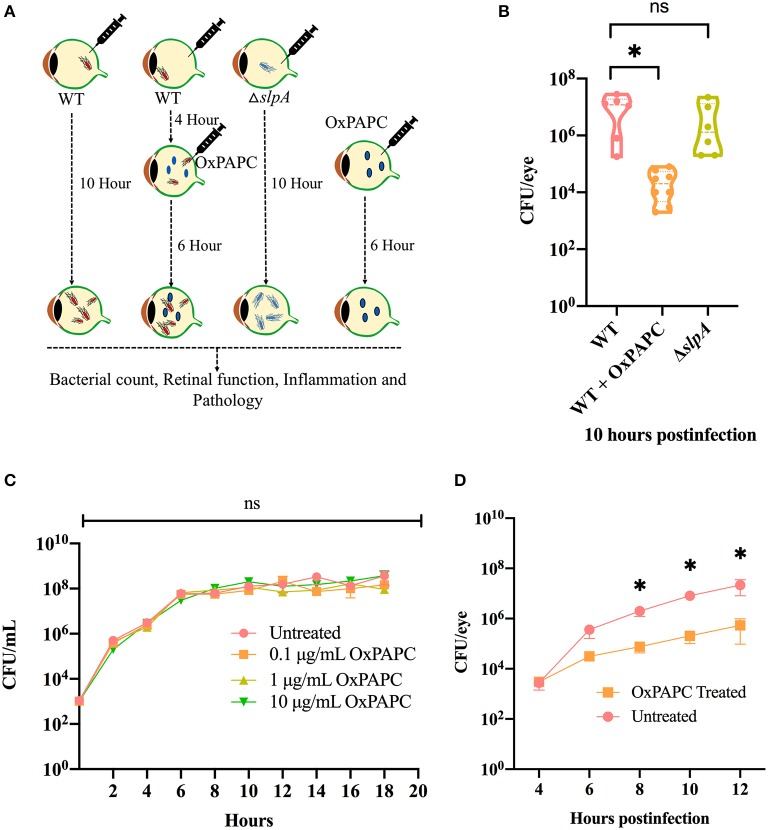
OxPAPC treatment resulted in reduced intraocular bacterial load during Bacillus endophthalmitis. (A) Experimental design of in vivo inhibition of TLR2/4 activation. (B) C57BL/6J mouse eyes were infected with 100 CFU WT or ΔslpA B. thuringiensis. At 4 h postinfection WT infected eyes were treated with 30 ng/μL OxPAPC. At 10 h postinfection eyes were harvested, homogenized, and analyzed for bacterial growth. Compared to untreated WT-infected C57BL/6J mouse eyes, a significant reduction in bacterial burden was observed in the OxPAPC-treated group at 10 h postinfection. No difference in intraocular bacterial count was observed between WT and ΔslpA infected eyes at 10 h postinfection. Values represent mean ± SEM of log10 CFU/eye of N ≥ 5 eyes for at least two separate experiments. (C) The in vitro growth of WT B. thuringiensis in BHI was not affected by the presence of 0.1, 1, or 10 μg/mL OxPAPC. Values represent the mean ± SEM of N = 3; multiple comparison, 2-way ANOVA (D) Treatment of eyes with OxPAPC 4 h after infection with 100 CFU of WT B. thuringiensis resulted in decreased bacterial growth. Data represent the mean ± SEM of log10 CFU/eye of N ≥ 5 eyes per time point for at least two separate experiments; ns: P > 0.05, *P < 0.05 at all time points.